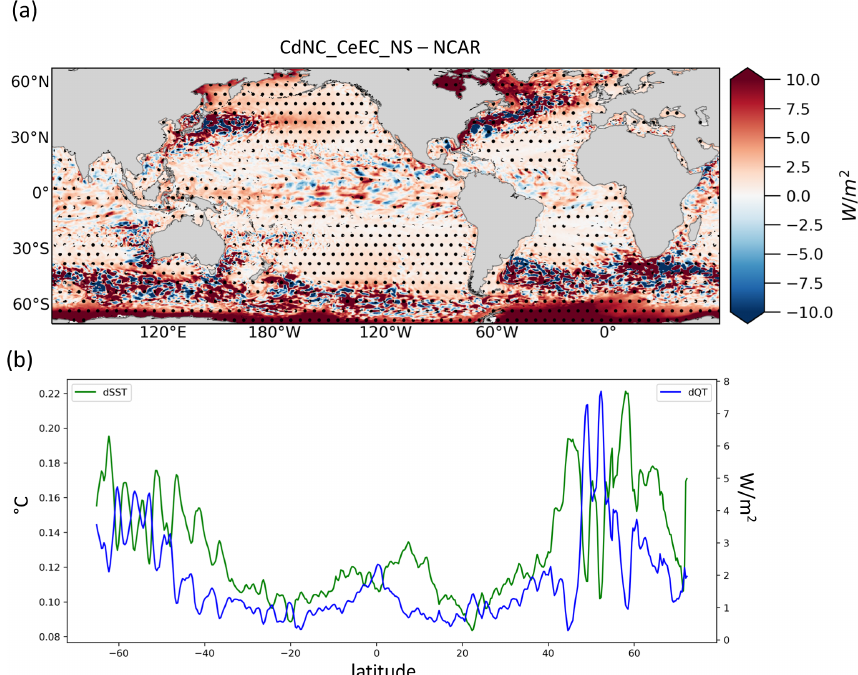
Figure 7. (a) Annual mean differences in total turbulent heat fluxes Q T between the CdNC_CeEC_NS and NCAR experiments. (b) Zonally averaged differences in SST (green) and Q T (blue) annual means between the same experiments. Hatching indicates significant values (95% confidence level).